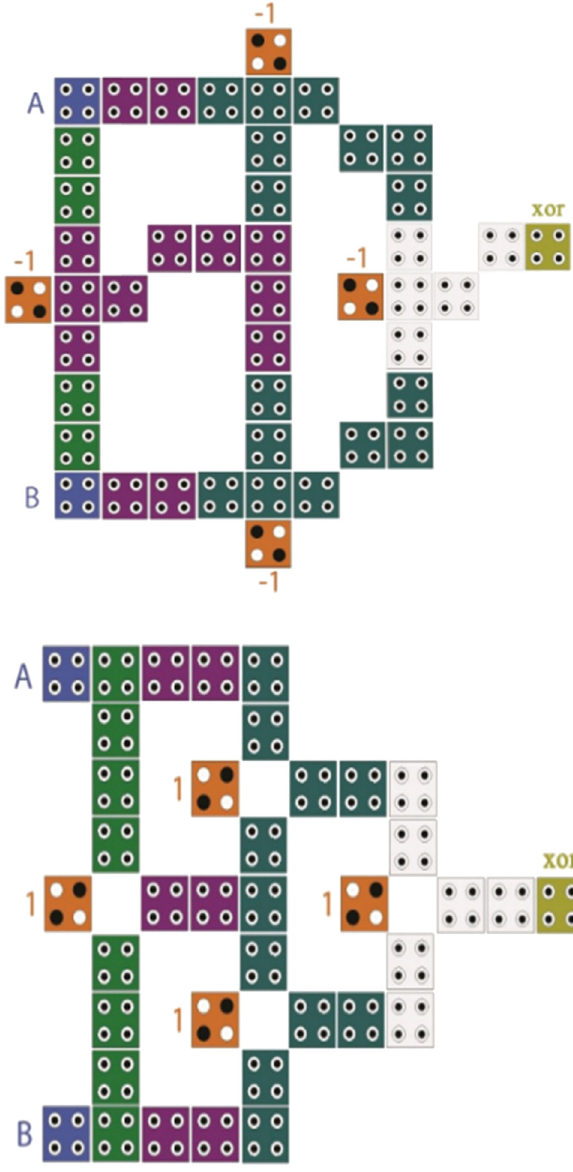
Figure 8: 2 - input XOR gate proposed in ref. [ 9 ] .